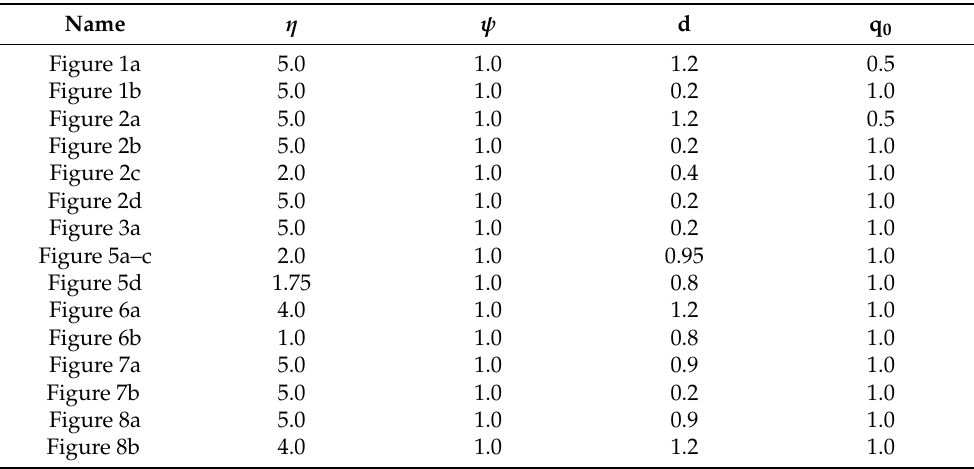
Table 3. Choice of parameters concerning cancerous cell